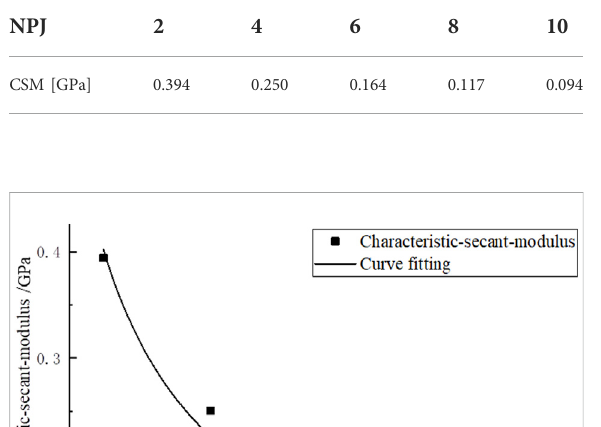
TABLE 9 Value of the characteristic size of the secant modulus.